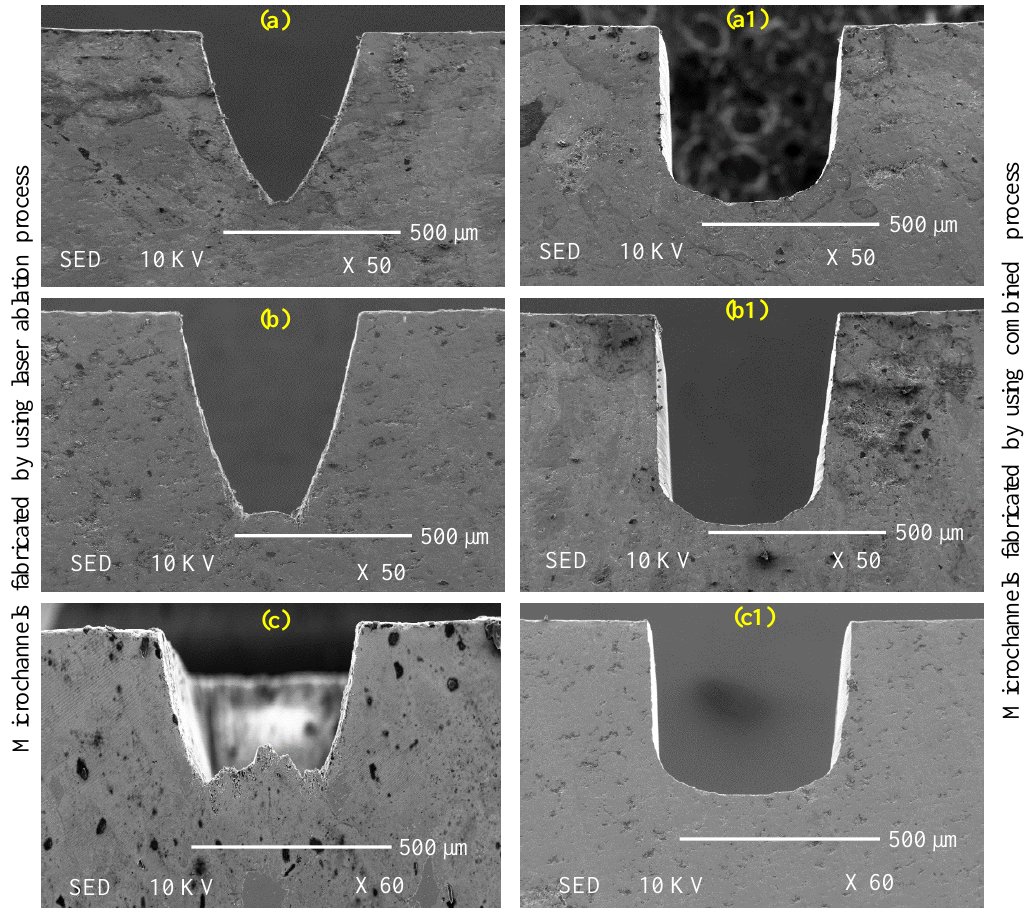
Figure 14. Comparison of the cross-sections of the fabricated channels by using LBM and combined LRUM processes: ( a , b and c ): cross-sections of the microchannels machined by using LBM process; ( a1 , b1 and c1 ): cross-sections of the microchannels machined by using LRUM combined process.